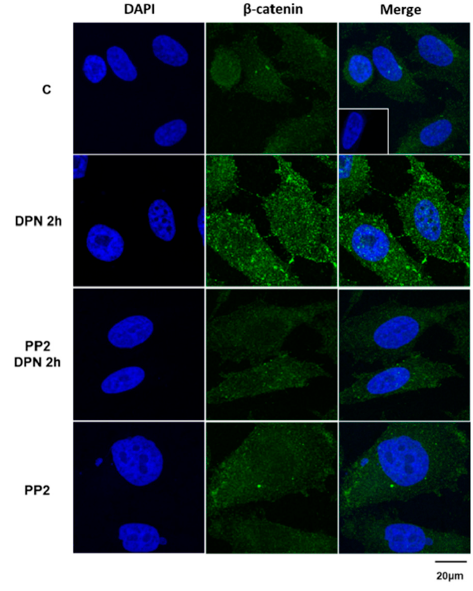
Figure 6. Effects of the selective inhibitor for SRC-family kinases (PP2) on the expression of non- phosphorylated β -catenin in androgen-independent prostate cancer cells PC-3 induced by DPN. Cells were incubated in the absence (C, control) and in the presence of DPN (10 nM) for 2 h at 37 °C. The cells were also pre-treated with PP2 (5 nM) for 30 min and then incubated or not with the DPN for 2 h. Positive immunostaining for non-phosphorylated β -catenin (green) was detected using the polyclonal antibody produced in rabbit by immunization with the synthetic peptide corresponding to the region around Serine 37 (Ser33/37/Thr41) of human β -catenin. Nuclei were stained with DAPI (blue). Negative control, in the absence of the primary antibody (detail). Results are representative of four independent experiments.